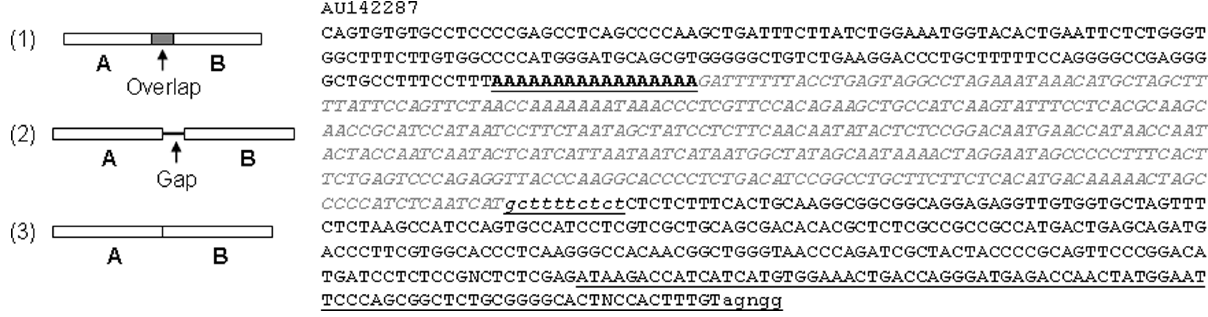
Figure 5. Poly-A as the gap between two fusion partners. Left panel : In a fusion RNA, two neighboring genes’ sequences have three relationships, i.e. 1) with an overlapped sequence, 2) with an unmatchable sequence as a gap, or 3) directly joined. Right panel : The 1–160th nt of EST AU142287 are matched the 429–588th nt of the last exon of the POLDIP3 mRNA from chromosome 22, followed by a poly-A tail (boldfaced and underlined). Since the wild type form of this exon should have 2248 nt, the polyadenylation actually follows an early transcriptional termination. The 178–526th nt region (italicized grey) after the poly-A is part of the ND2 mRNA from mtDNA. The 527–836th nt sequence belongs to the first two exons of the GNB2L1 mRNA from chromosome 5, with the first 10 nt (underlined lowercase letters) alternatively initiated from the 2 10 bp of the GNB2L1 gene. The last 85 nt (underlined) have a few deletion mismatches to the first 88 nt of exon 2 of the GNB2L1. The last 5 nt (agngg) are unmatchable and might belong to the cloning vector.